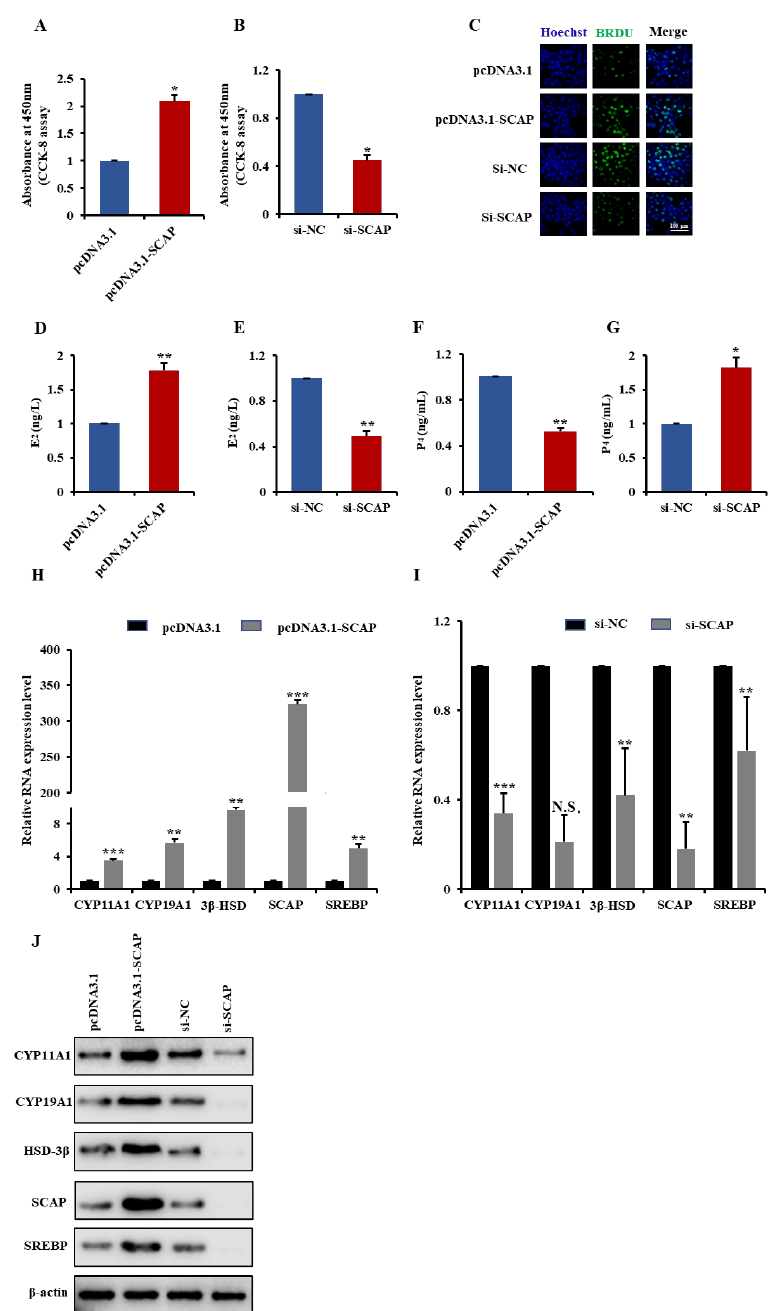
Figure 7. SCAP promotes GCs steroidogenesis and proliferation. ( A , B ) CCK-8 assay was performed to assess the effect of SCAP overexpression and knockdown on GCs proliferation. ( C ) BrdU analysis was performed to assess the effect of SCAP overexpression and knockdown on GCs proliferation; scale bars are 100 µ m. ( D , E ) Detection of E 2 concentrations in GCs transfected with pcDNA3.1-SCAP and pcDNA3.1 empty plasmids, i.e., si-SCAP and si-NC. ( F , G ) Detection of P 4 concentrations in GCs transfected with pcDNA3.1-SCAP and pcDNA3.1 empty plasmids, i.e., si-SCAP and si-NC. ( H , I ) RT-qPCR was used to examine the effect of overexpression and knockdown of SCAP on the expression levels of steroidogenesis-related (CYP11A1, CYP19A1, and 3 β -HSD) and sterol regulation- related (SCAP and SREBP) mRNAs in GCs. ( J ) Overexpression and knockdown of SCAP affected the expression of steroidogenesis-related proteins and sterol regulatory element proteins. Values represent means ± SEM for three individuals. * p < 0.05; ** p < 0.01; *** p < 0.001. N.S., not